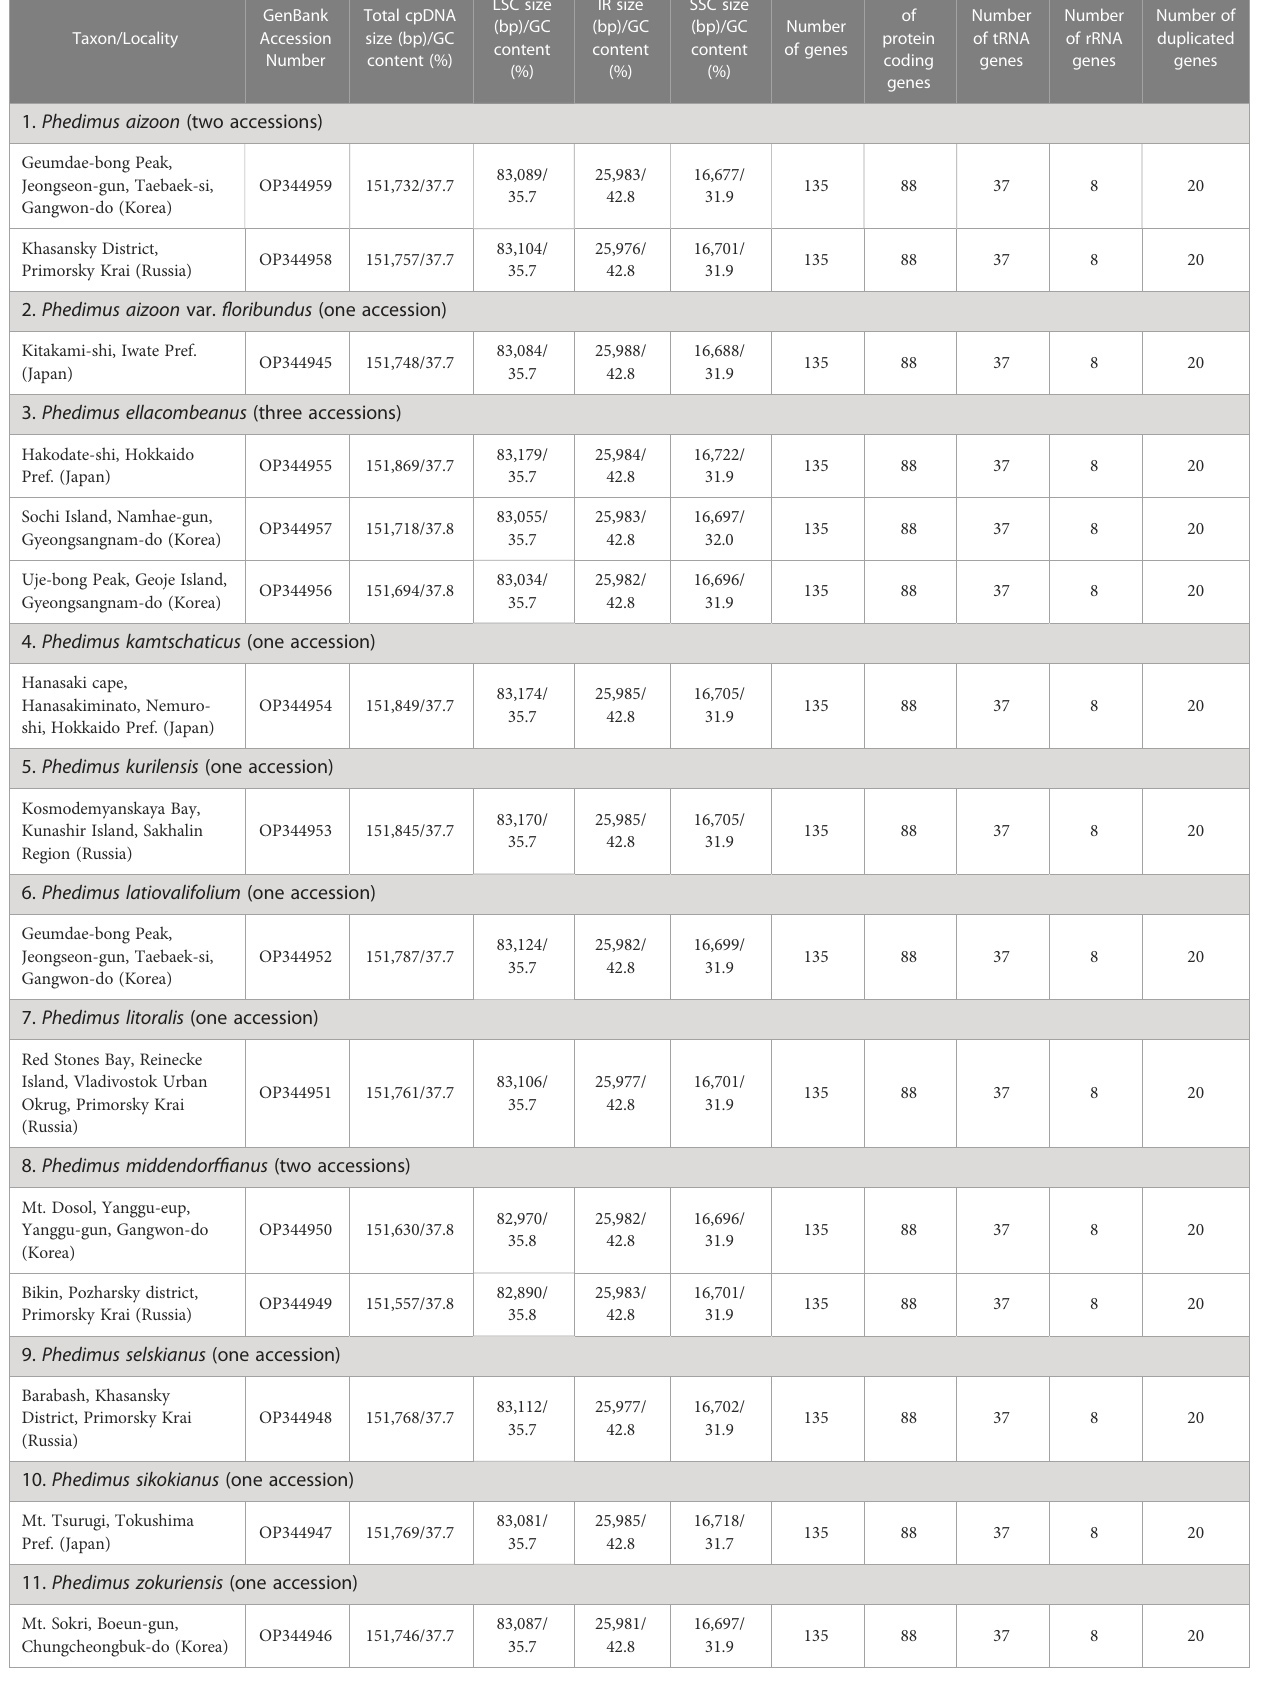
TABLE 1 Characteristics of plastomes of the 15 Phedimus subg. Aizoon accessions used in this study.